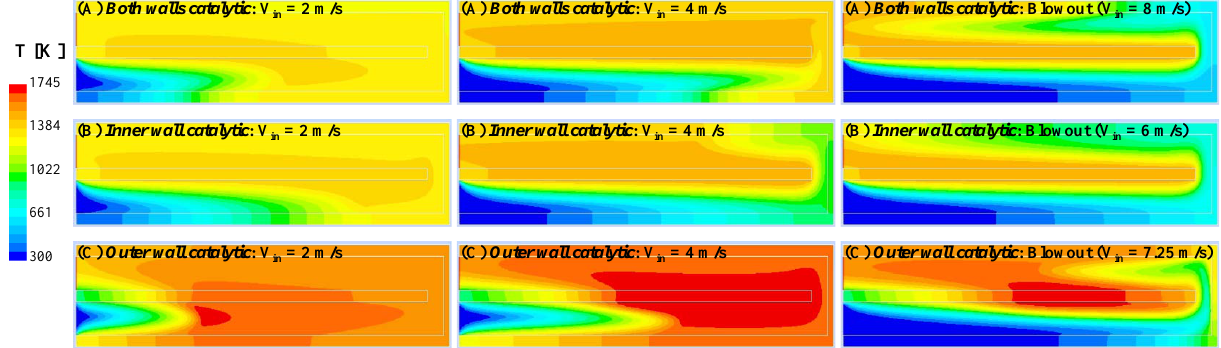
Figure 6. Contours of temperature at different values of V in ( left : 2 m/s; middle : 4 m/s; right : (near) blowout) for the three reactor configurations of Figure 1 with different catalyst placement. Low thermal conductivity (3 W/(m K)). The computational domain is scaled along the transverse direction by a factor of